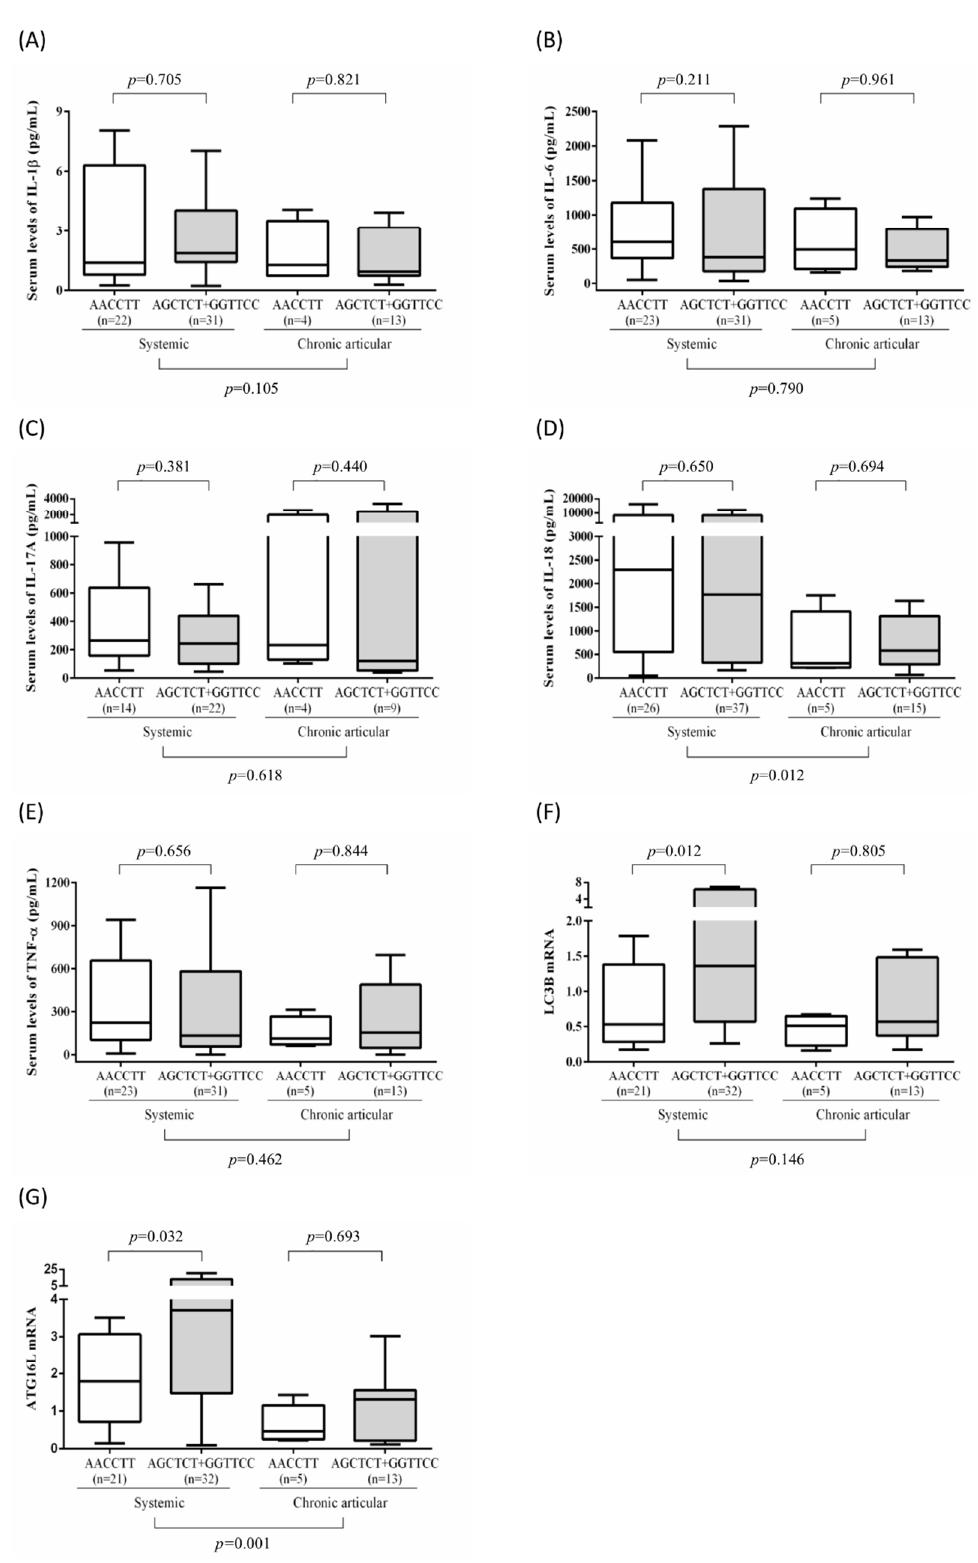
Figure 3. ( A – G ) Serum levels of IL-1 β , TNF- α , IL-6, IL-17A, and IL-18, and mRNA levels of LC3-II and ATGL16L1 in patients with AOSD carrying different